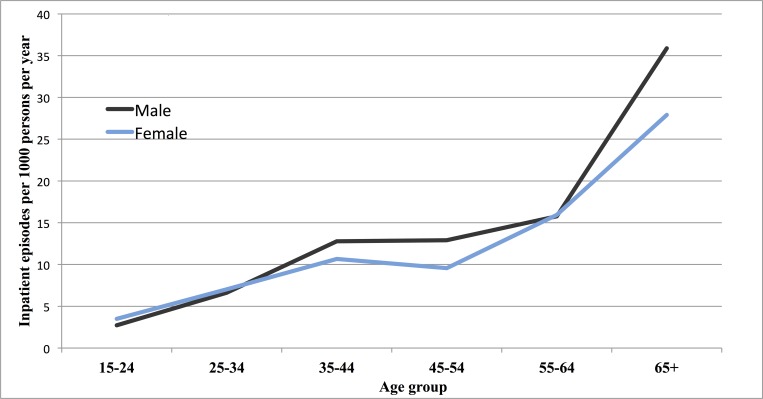
Annual incidence of inpatient admissions per 1000 population, by age and sex, Blantyre District, Malawi 2013–2015.The grey line represents ‘Male’, the light blue line represents ‘Female’.